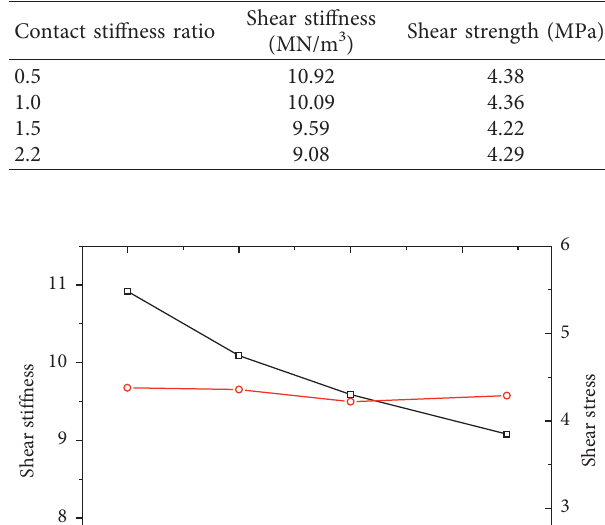
Figure 4: Shear deformation curves of bolted and unbolted joints under different contact stiffness ratios. Table 5: Relationship between contact stiffness ratio and shear stiffness.